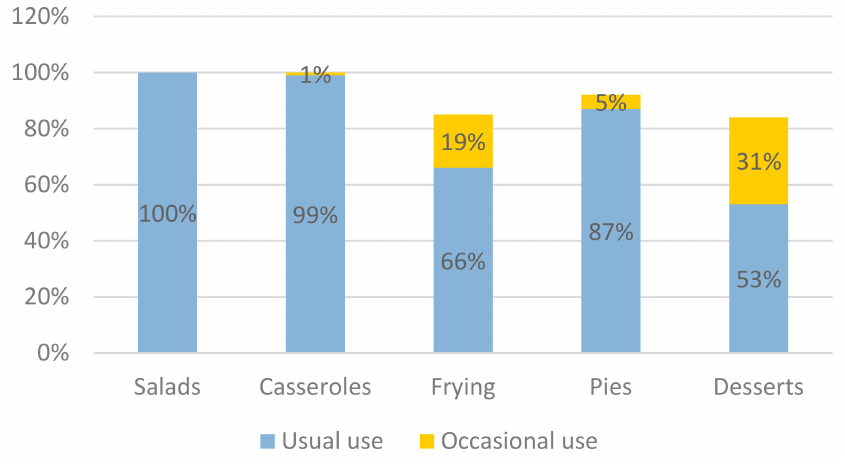
Figure 2. Usual and occasional use of olive oil in food preparation in Greek